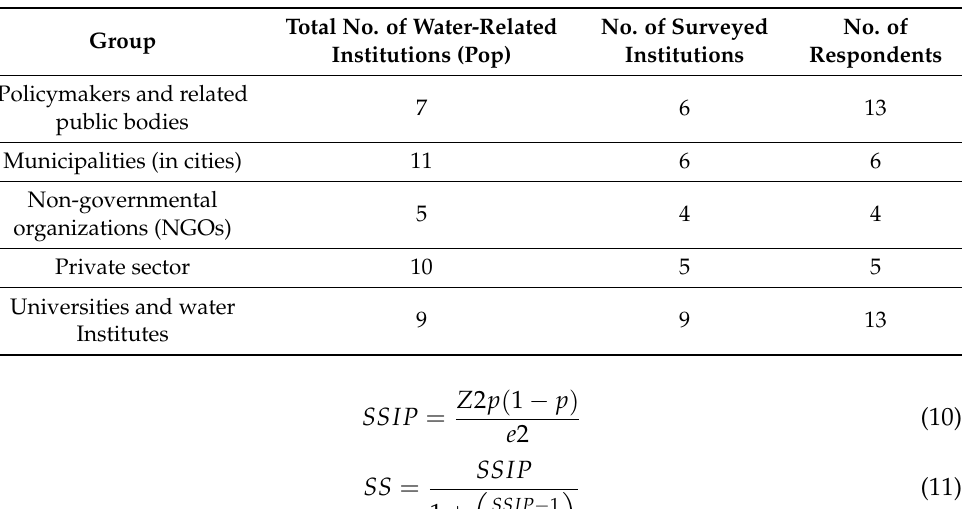
Table 3. Targeted water-related bodies for the groundwater quality survey.